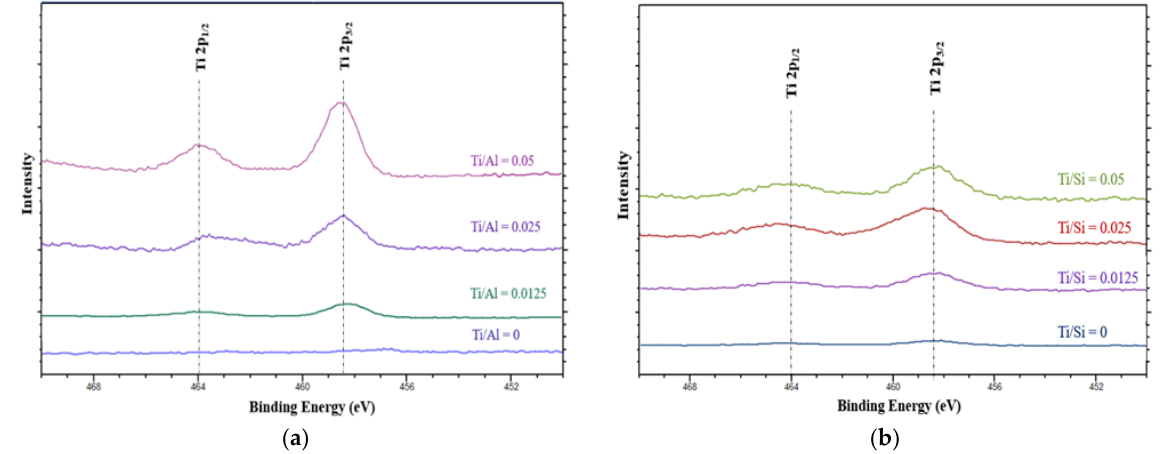
Figure 5. Ti 2p XPS of ( a ) HPMo/Ti-Al 2 O 3 and ( b ) HPMo/Ti-TUD-1 catalysts.